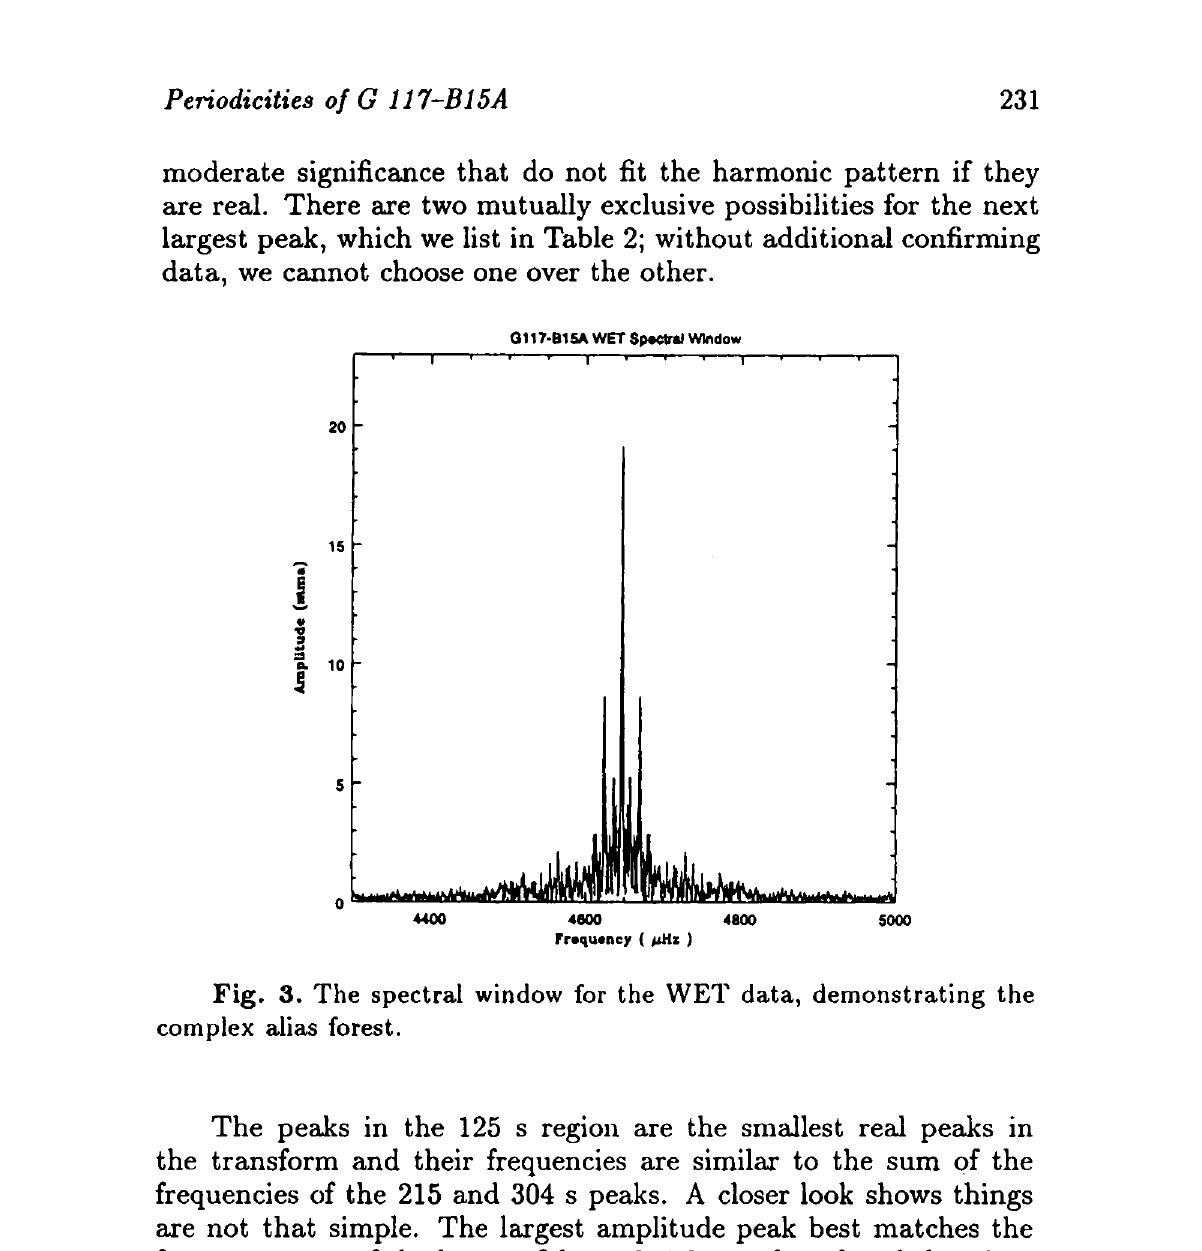
Fig. 3. The spectral window for the WET data, demonstrating the complex alias